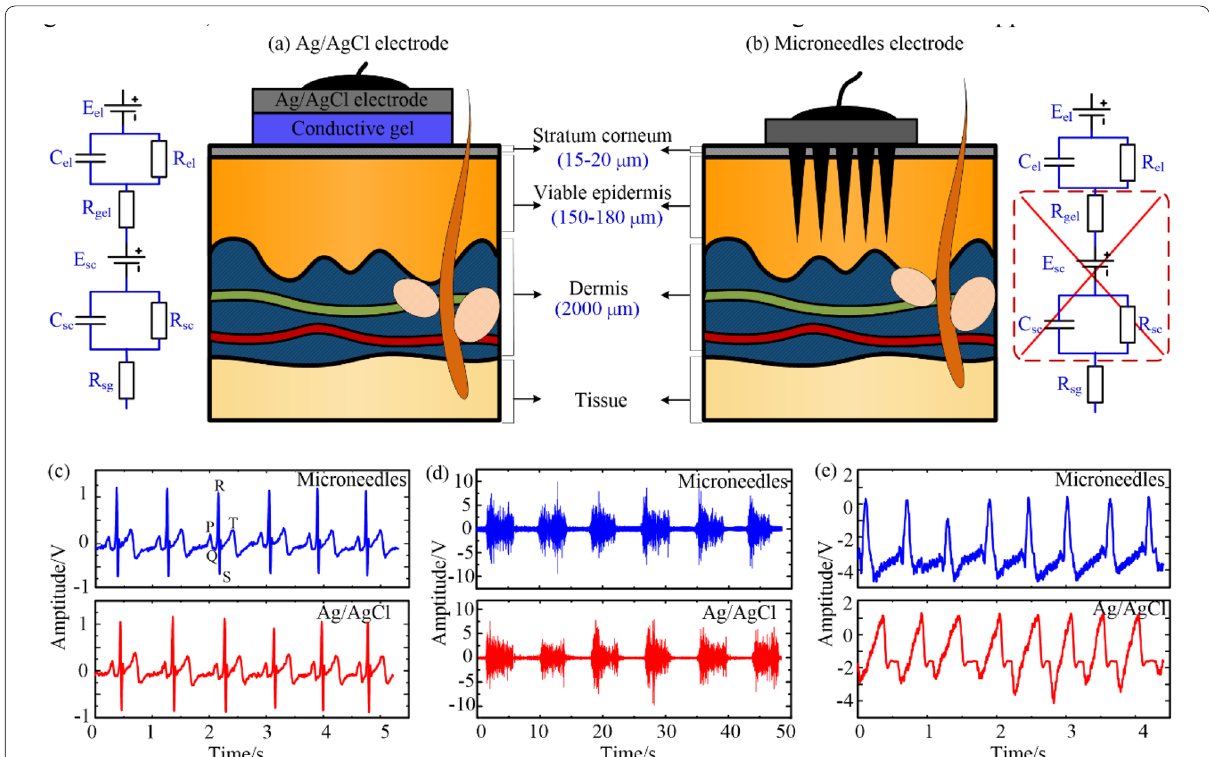
Figure 3 Typical bio-signals measured by Ag/AgCl electrode and microneedles electrode: a measure principle and equivalent circuit model of Ag/ AgCl electrode, b measure principle and equivalent circuit model of microneedles electrode, c ECG, d EMG, e